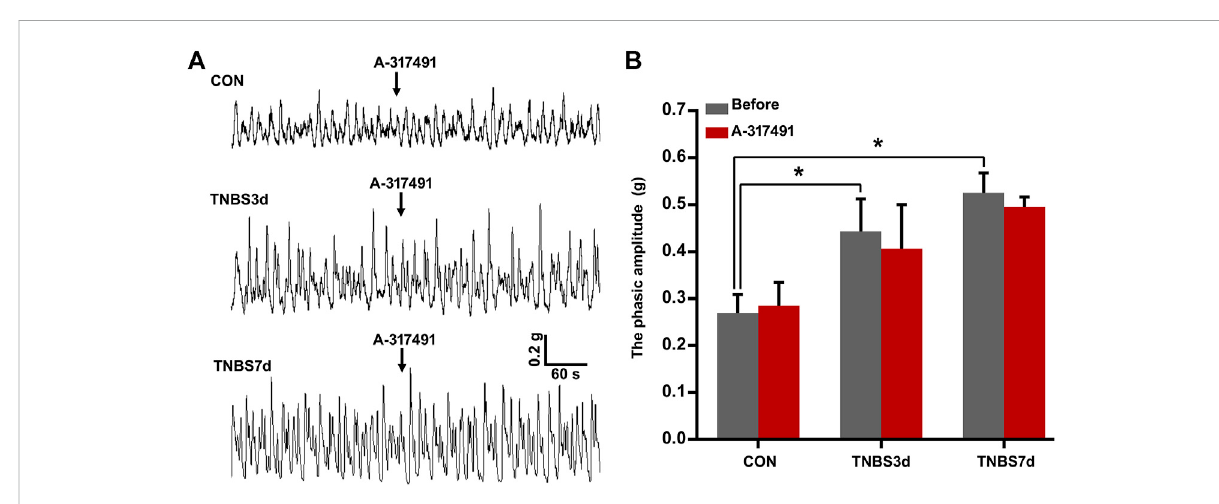
FIGURE 5 Spontaneous contractions of the detrusor strip isolated from the bladder of three groups had no sensitivity to the inhibition of P2X3 receptors. (A) Representative tracers of detrusor strip contractility responded to A-317491. The detrusor strip isolated from colitis rats exhibited the characteristic of detrusor overactivity. n = 4 for each group. (B) Histogram showed that TNBS-induced colitis signi fi cantly increased the phasic amplitude of detrusor strip contractility compared to the control group, but treatment with A-317491 had no effect on the detrusor strip contractility isolated from both control and colitis groups. * p < 0.05 by one-way ANOVA followed by Newman – Keuls post hoc